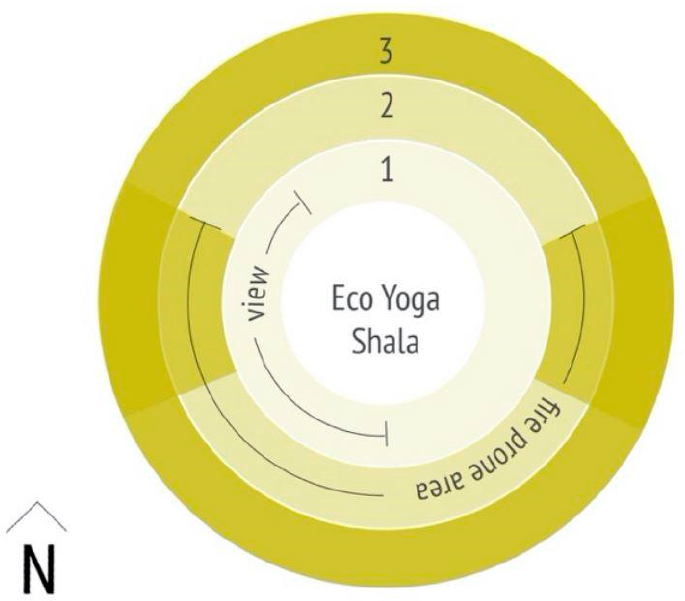
Figure 6. Tri Shala’s zones and sectors affected by external natural energies (1) view, (2) fire prone areas and (3) weather elements (Source: compiled by the author).